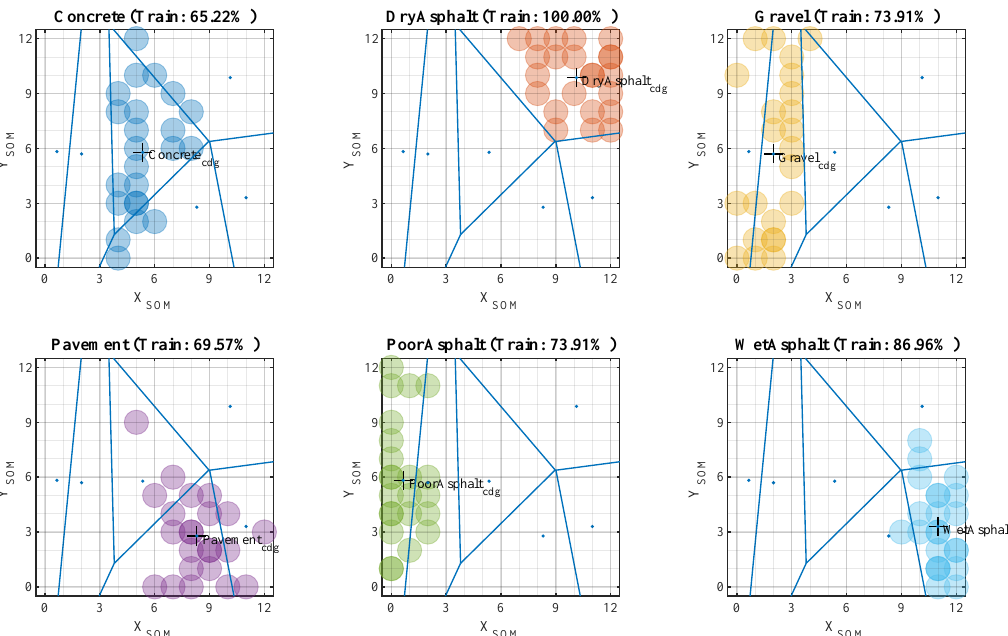
Figure 8. Sample classification using self-organizing maps—training phase (cluster generation).